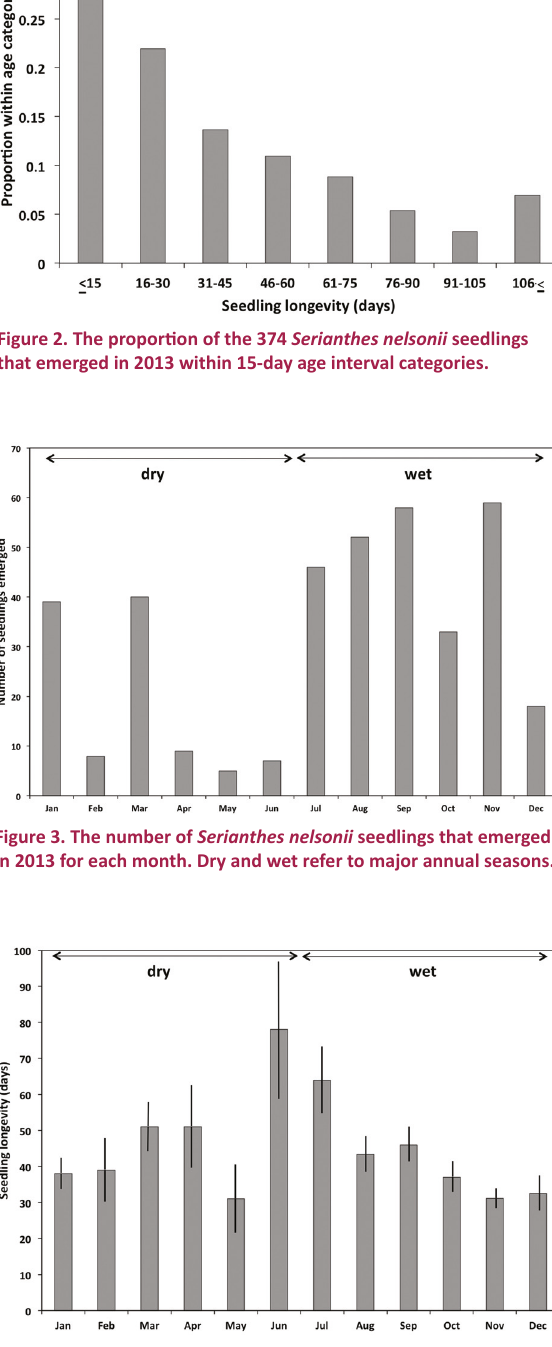
Figure 4. Mean longevity of the 374 Serianthes nelsonii seedlings that emerged in 2013 as a function of month. Dry and wet refer to major annual